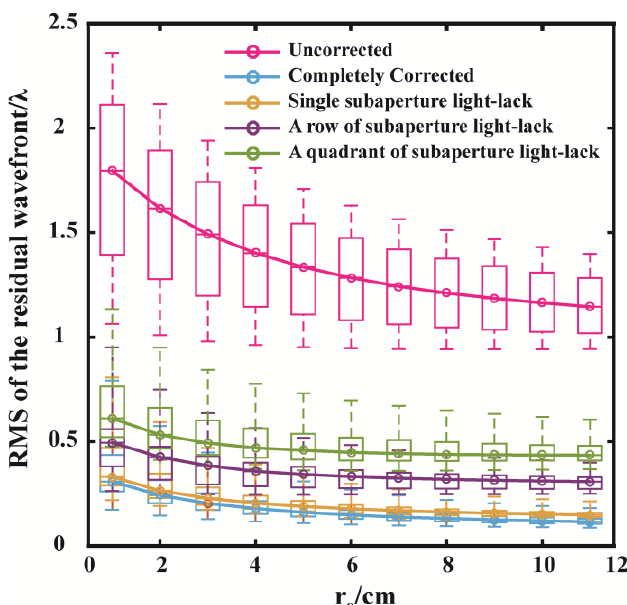
Figure 13. For the case of mixed aberration wavefront, RMS of the residual wavefront varies with different values of r 0 under the conditions of uncorrected, completely corrected, single sub-aperture lack of light, a row of sub-apertures lack of light, and a quadrant of sub-apertures lack of light. The RMS of the three cases with under-sampling can be reduced by a factor of 5~8, 3.5, and 3 compared with the uncorrected result.